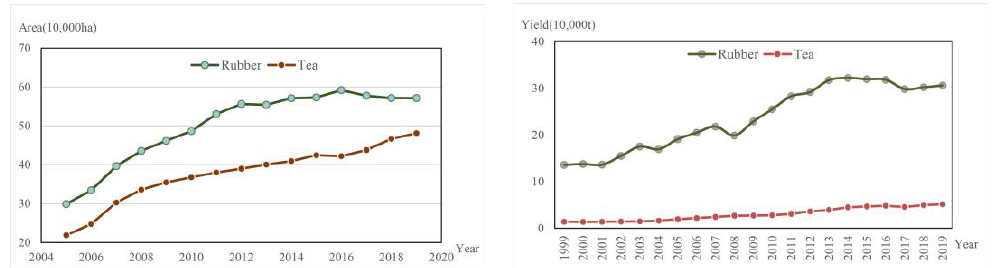
Figure 4. Rubbe r and tea production areas and yields in Xishuangbanna and Pu’er over time . Figure 4. Rubber and tea production areas and yields in Xishuangbanna and Pu’er over